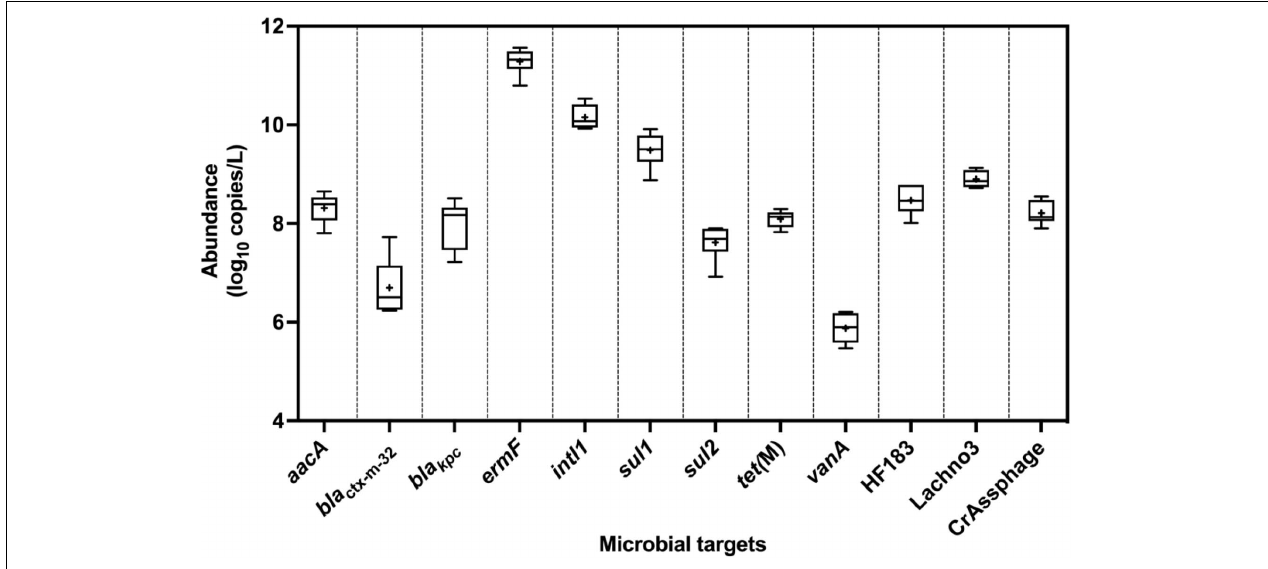
FIGURE 2 | Abundance (log 10 copies/L) of ARGs ( aacA , bla ctx − m − 32 , bla KPC , ermF , sul1 , sul2 , tet(M) , and vanA ), intl1 , and sewage-associated marker genes (HF183, crAssphage CPQ_056, and Lachno3) in untreated sewage samples, which were always detected in quantifiable abundances. ARG bla VIM was